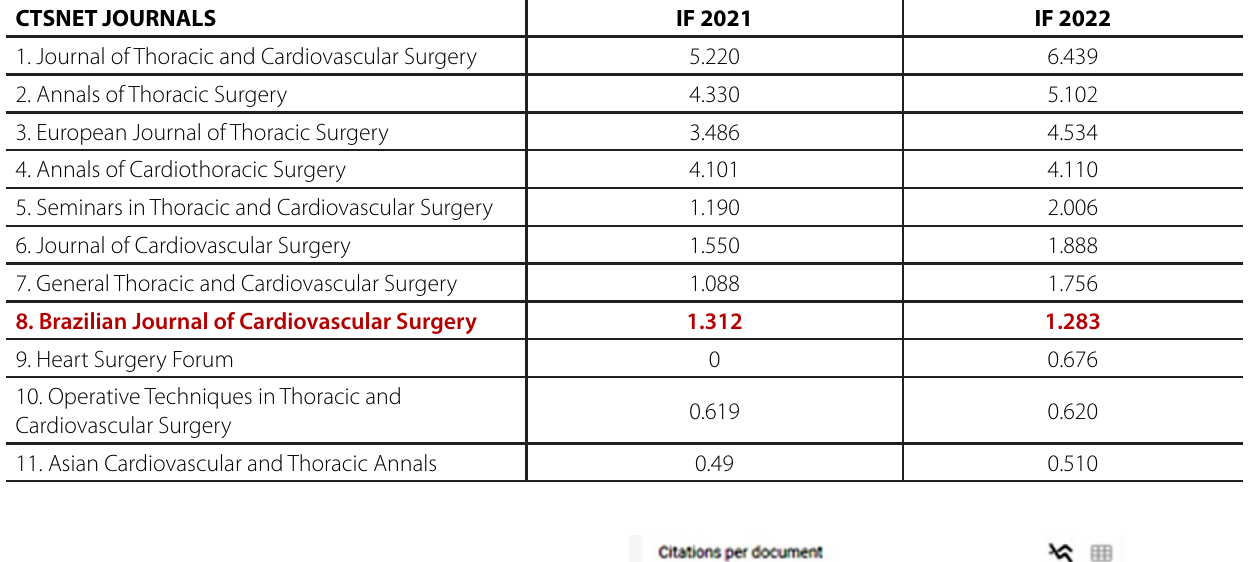
Table 1. Cardiothoracic Surgery Network (CTSNET) journals. CTSNET JOURNALS